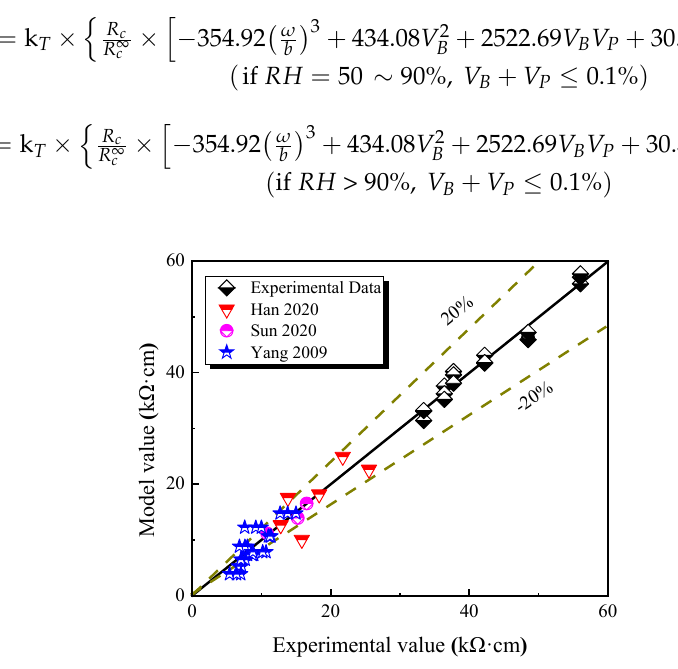
Figure 6. Comparison of experimental and predicted value [19,28,49].